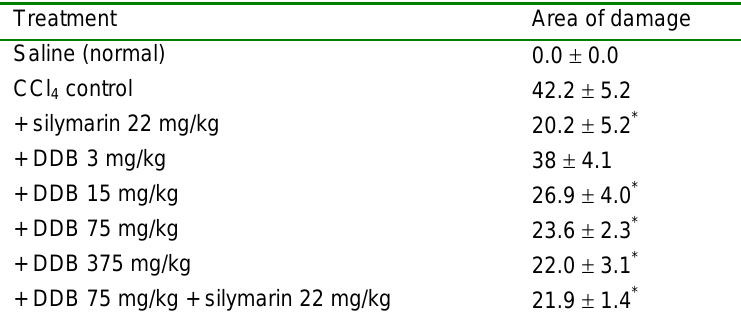
Quantitative study of the area of fibrosis in different